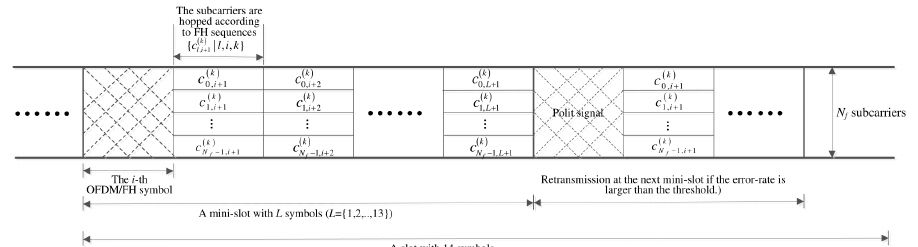
Figure 4. The time–frequency domains of the OFDM/FH system based on the mini-slot